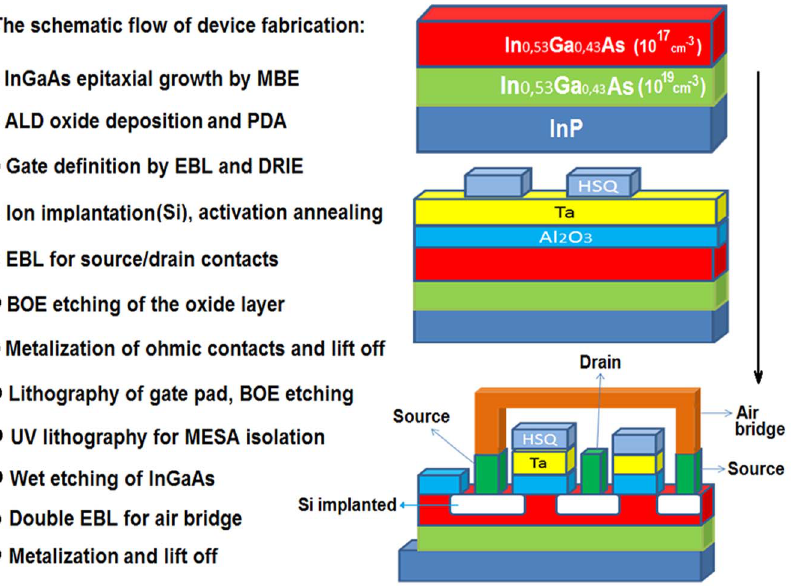
Figure 1. Schematic flow of fabrication for self-aligned n-type In 0.53 Ga 0.47 As with the air bridge.